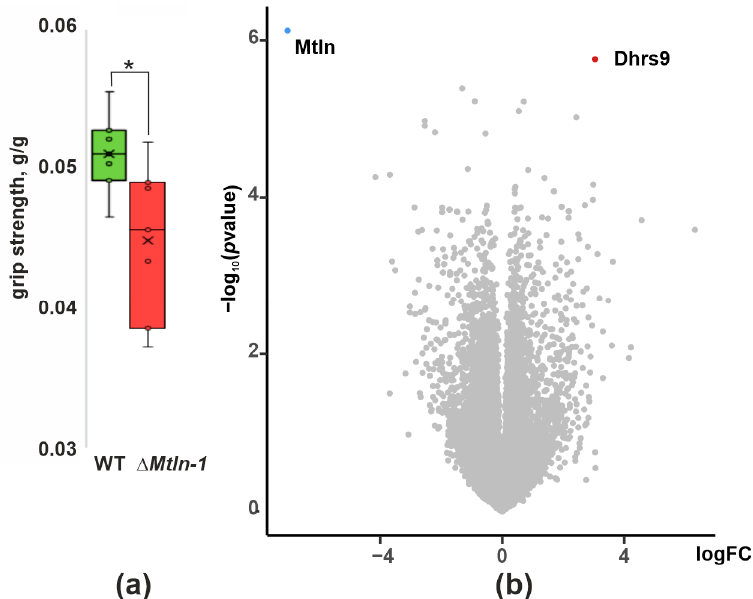
Figure 1. Influence of Mtln inactivation on integrative characteristics of muscle. ( a ) Forelimb grip strength of the wild type (green bar, n = 10) and ∆ Mtln-1 (red bar, n = 13) male mice after 24 h food deprivation; interquartile ranges are shown as solid bars, while the all-data range is shown by thin lines. The horizontal line corresponds to the median, while the cross to the average. The significance level calculated using the Student’s t -test is shown; If a p -value is less than 0.05, it is flagged with one star (*) ( b ) Differential gene expression in the soleus muscle of the wild type and ∆ Mtln-1 knockout mice. Volcano plot of differentially expressed genes. The x-axis corresponds to the log-scale fold change of expression, Δ Mtln-1 relative to the wild type, while the y-axis corresponds to p -value.